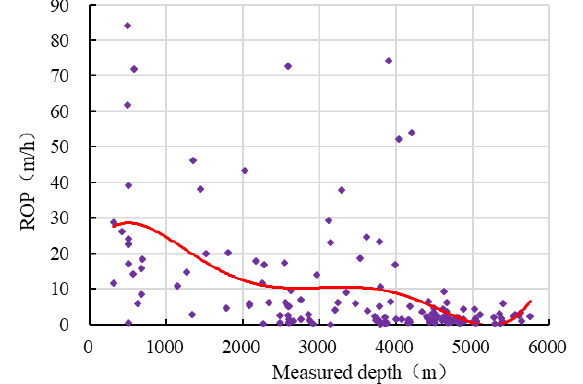
Fig. 6. Variation between ROP and measured depth